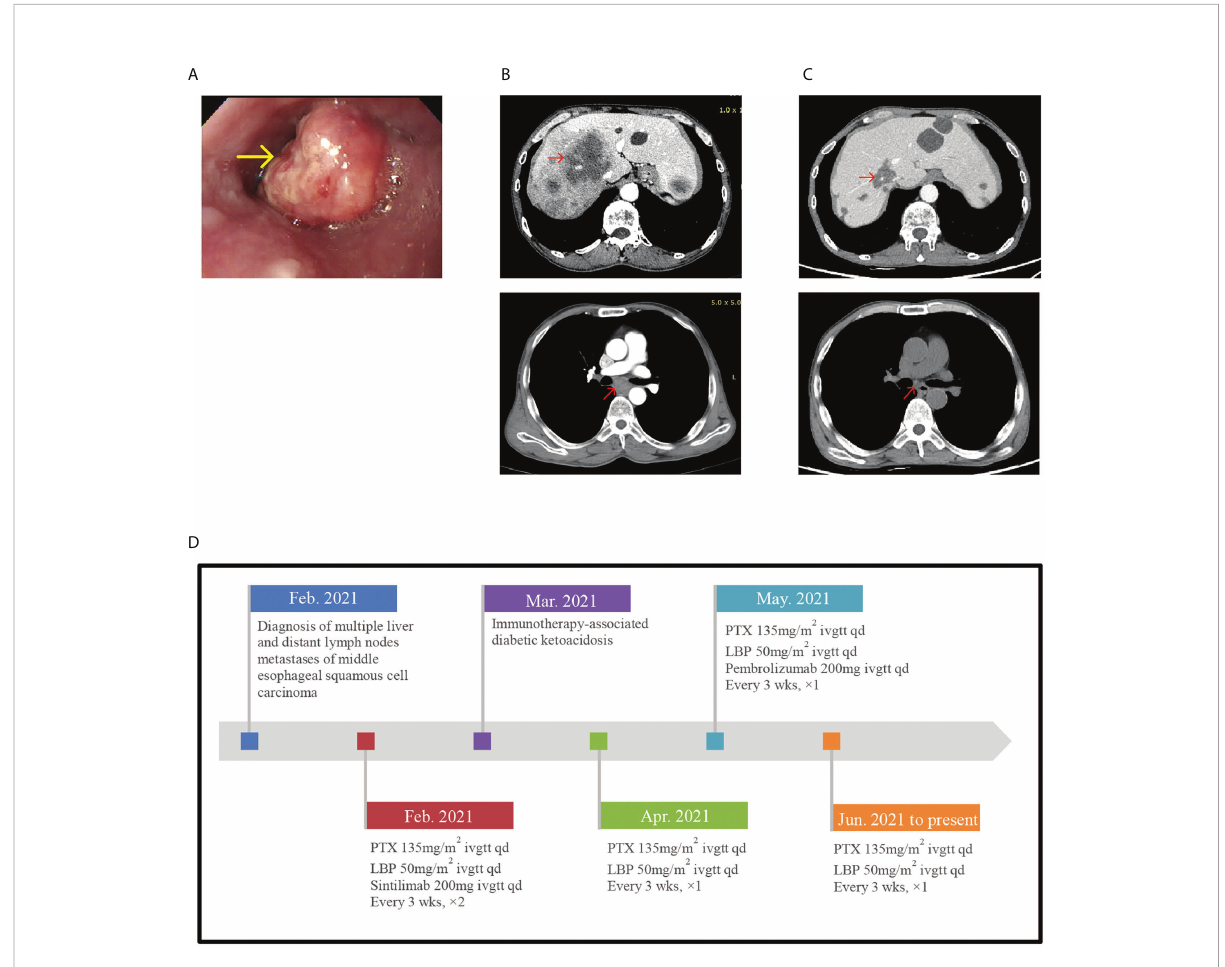
FIGURE 2 (A) Endoscope images showing esophageal neoplasm. (B) In February 2021, pretreatment CT-scan showed multiple livermetastases and supraclavicular and subcarinal lymph node metastases. (C) In June 2021, posttreatment CT-scan showed the tumor regression. (D) Timeline of diagnosis, detailed treatment protocols since February 2021 till